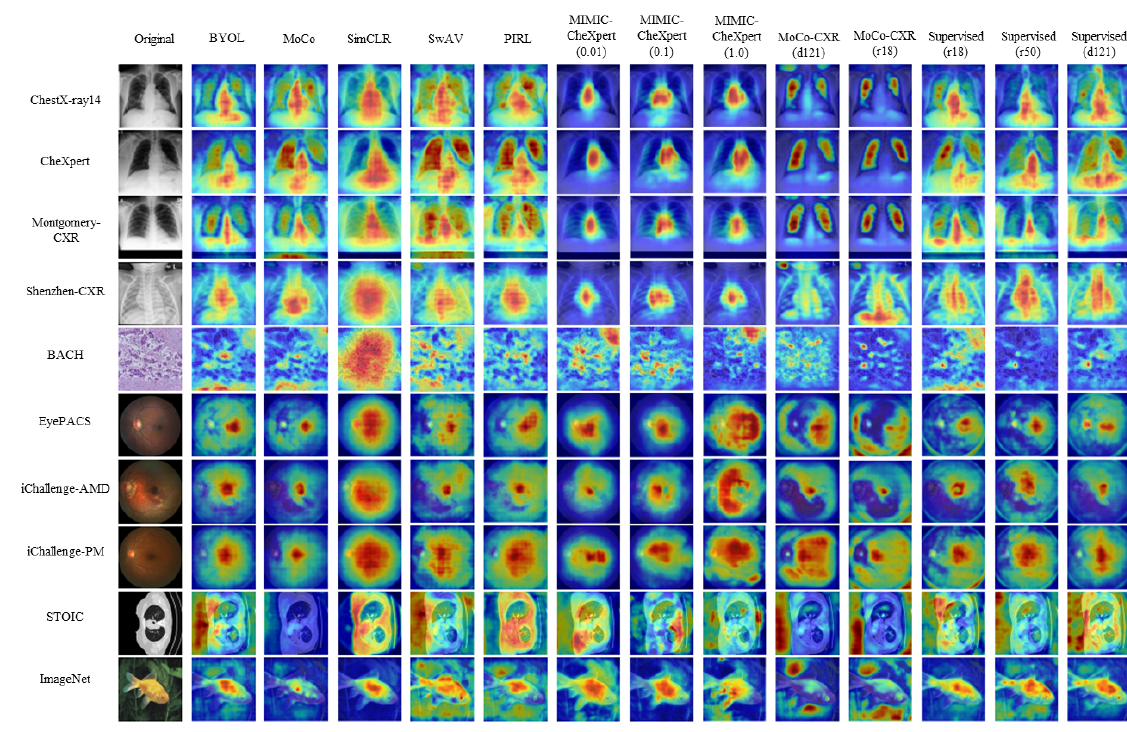
Figure A6. Saliency maps for all models on one image from each